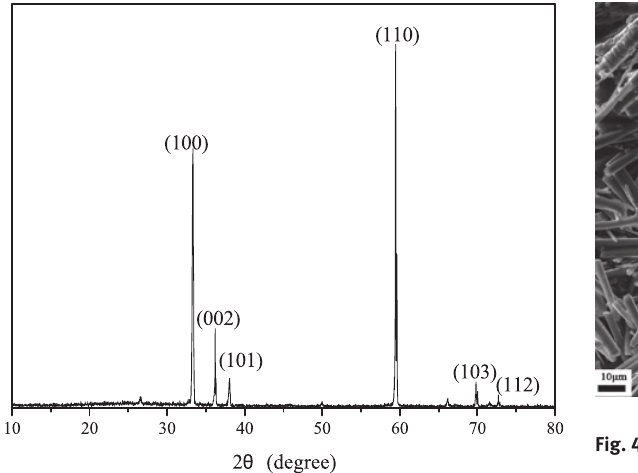
Fig. 2: XRD pattern of AlN whiskers